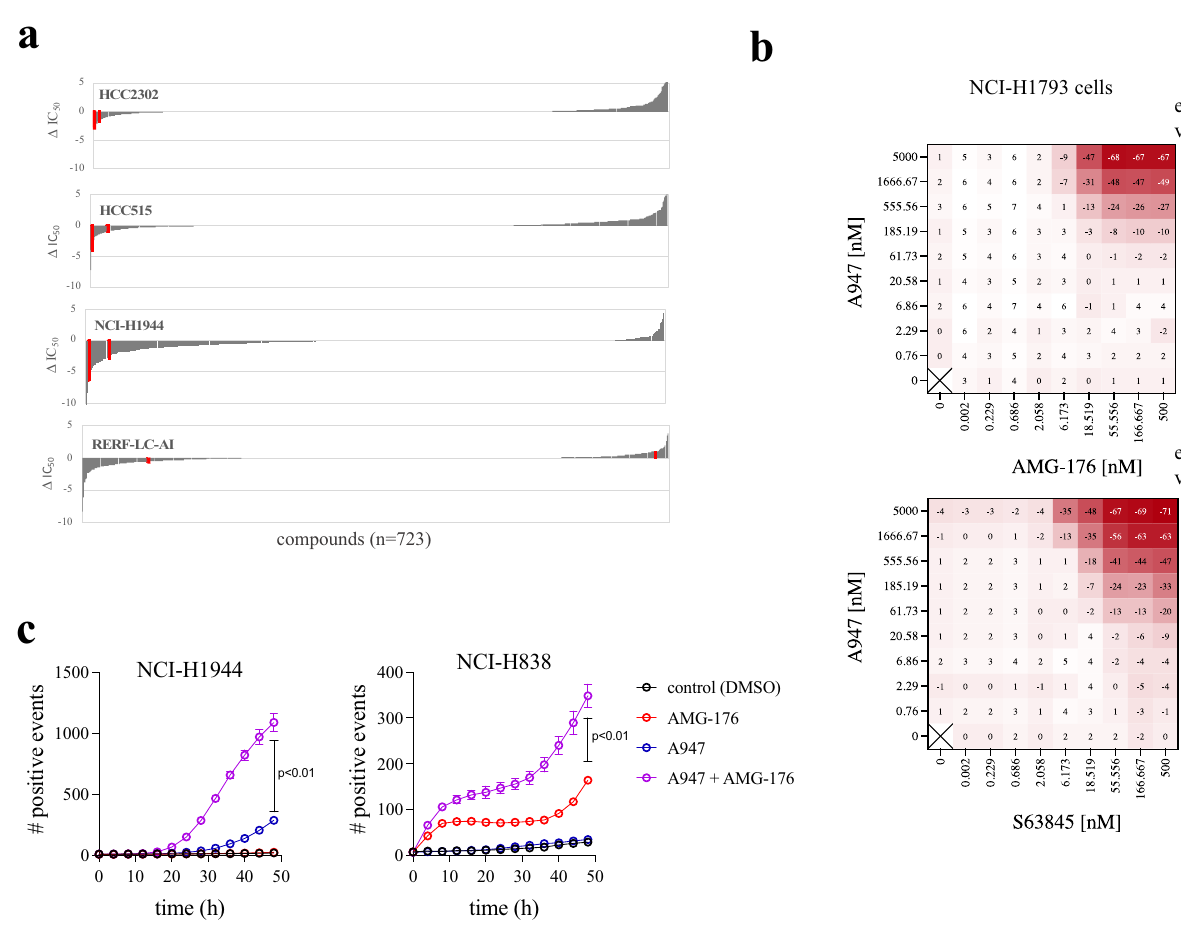
Fig.5|A947-mediatedSMARCA2degradationsynergizeswithMCL1inhibition. a Cell viability in 4 SMARCA4 mutant NSCLC cell lines measured across a small- moleculelibraryof723compoundsscreenedasadose-responseinthepresenceor absence of 100nM A947 for 5 days. Data are plotted as the difference in the con- centrationrequiredtoinhibitgrowthby50%( Δ IC 50 )upon − /+A947treatment.Two separate MCL1 inhibitors are annotated in red. b Treatment of a representative SMARCA4-mutantcellline(NCI-H1793)witha9×9matrixtitrationofA947withthe MCL1 inhibitors, AMG-176 (upper plot) and S63845 (lower plot). Heatmaps depict